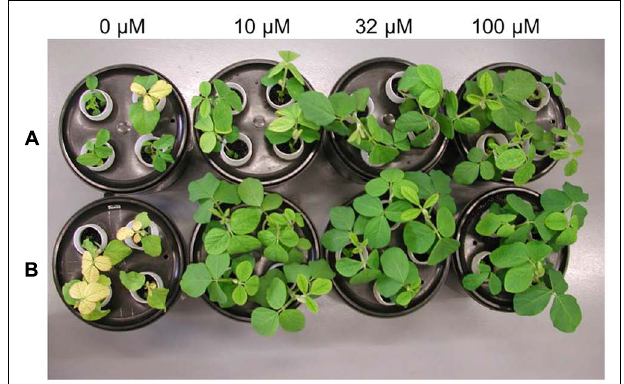
FIGURE 1 |Wild-type (PanelA) and transgenic 392-3 (Panel B) soybean plants at 14 days of hydroponic growth supplemented with 0, 10, 32, or 100 μ M Fe(III) EDDHA (left to